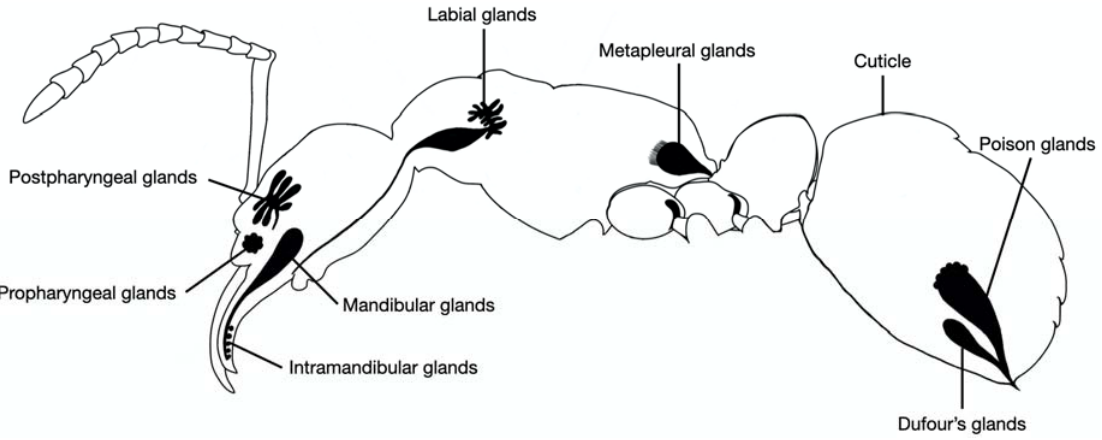
Figure 3. Schematic diagram of green tree ant’s exocrine glands.